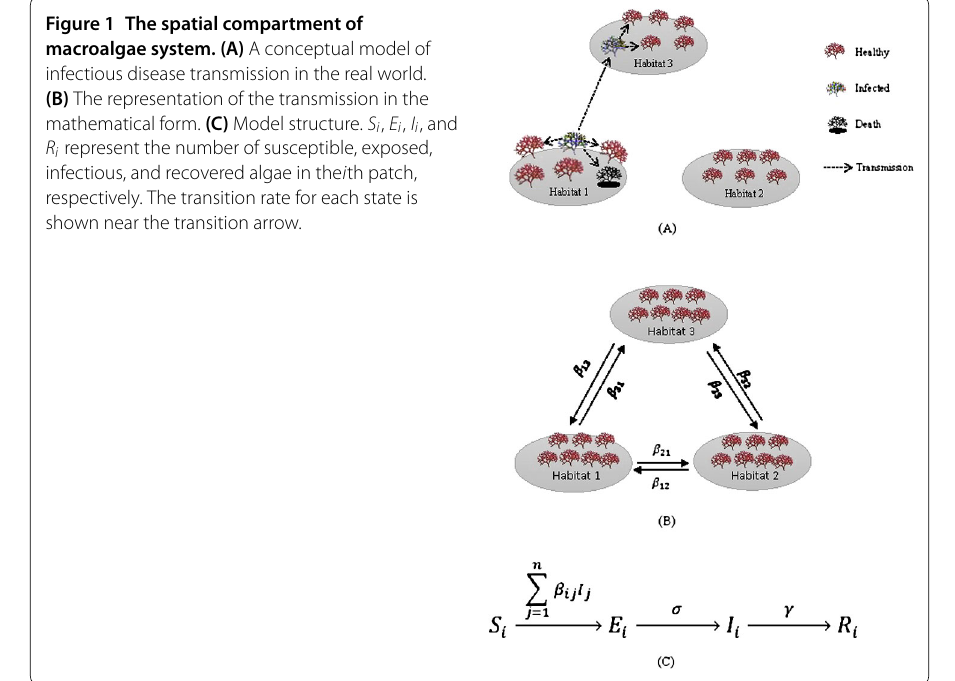
Figure 1 The spatial compartment of macroalgae system. (A) A conceptual model of infectious disease transmission in the real world. (B) The representation of the transmission in the mathematical form. (C) Model structure. S i , E i , I i , and R i represent the number of susceptible, exposed, infectious, and recovered algae in the i th patch, respectively. The transition rate for each state is shown near the transition arrow.